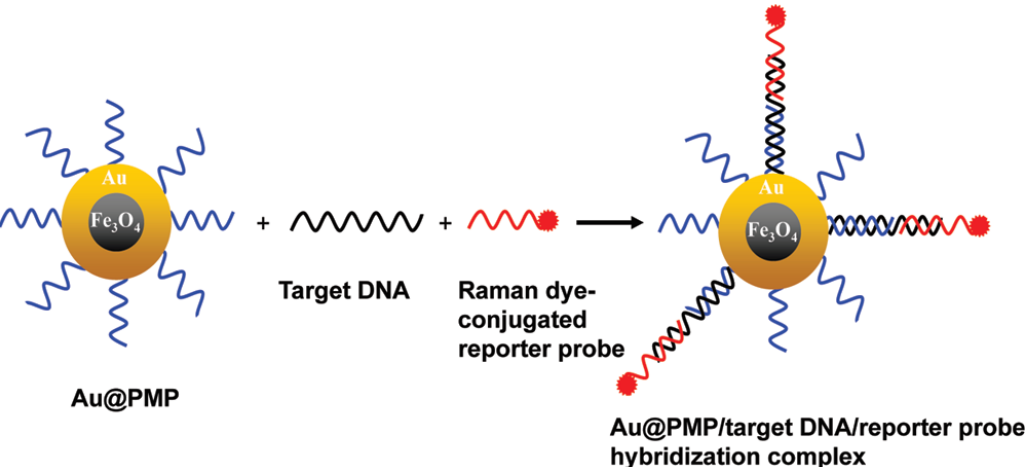
Figure 2. ASO-based identification of viral genomes in nanoparticle solution. High specificity is achieved due to a ternary complex with ASO labeled with a Raman-active compound. Reproduced with permission from [54]. Copyright American Chemical Society, 2012.